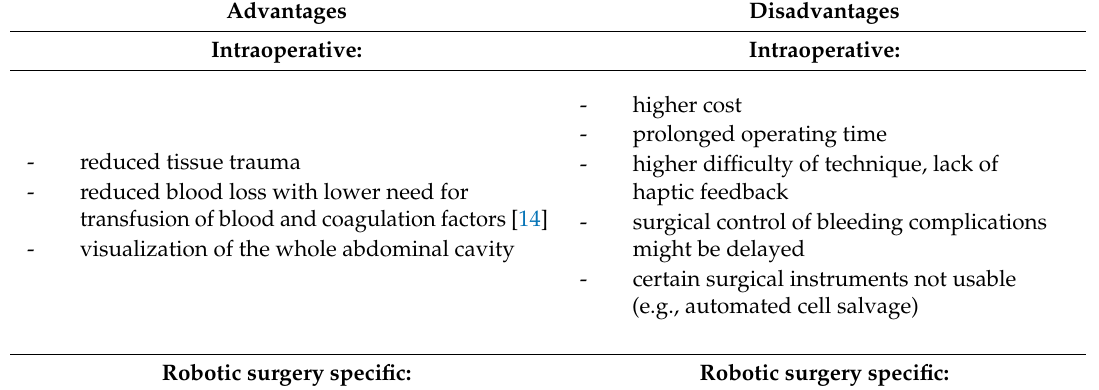
Table 1. Surgical advantages and disadvantages of laparoscopic and robotic surgery